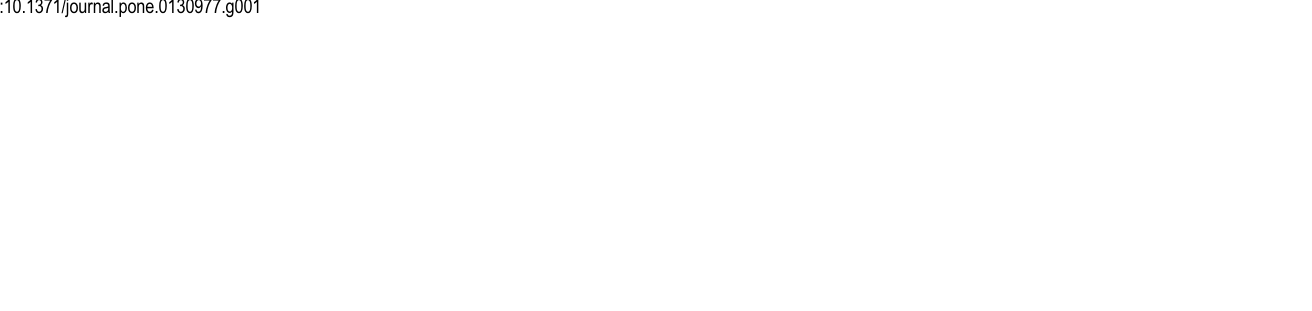
PLOS ONE | DOI:10.1371/journal.pone.0130977 July 20,